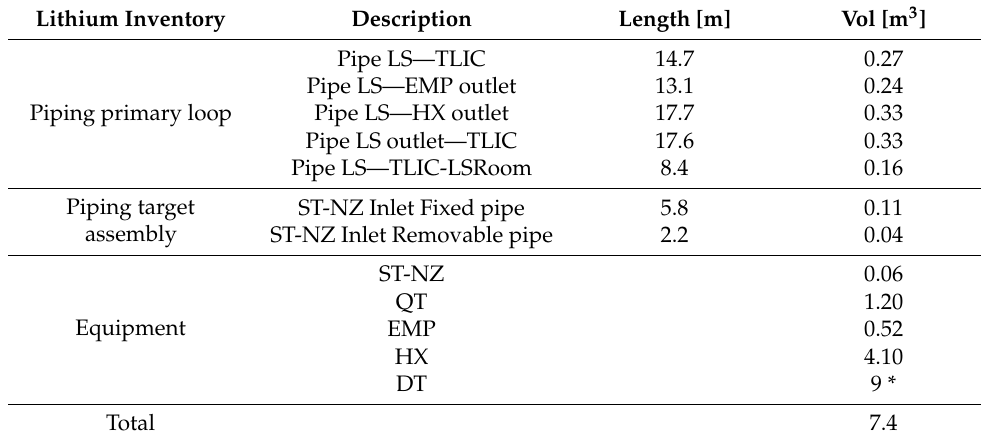
Table 1. Lithium inventory. * DT volume is empty during operation.